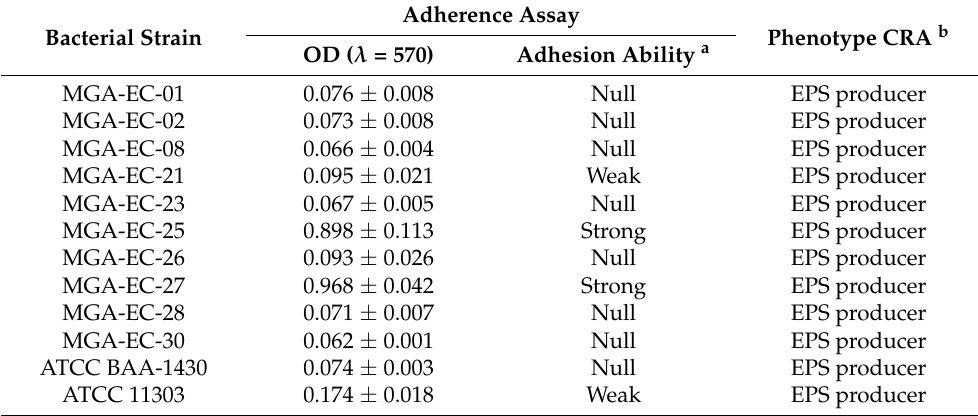
Table 1. Characterization of the biofilm formation ability of the E. coli strains used in this study. Bacterial